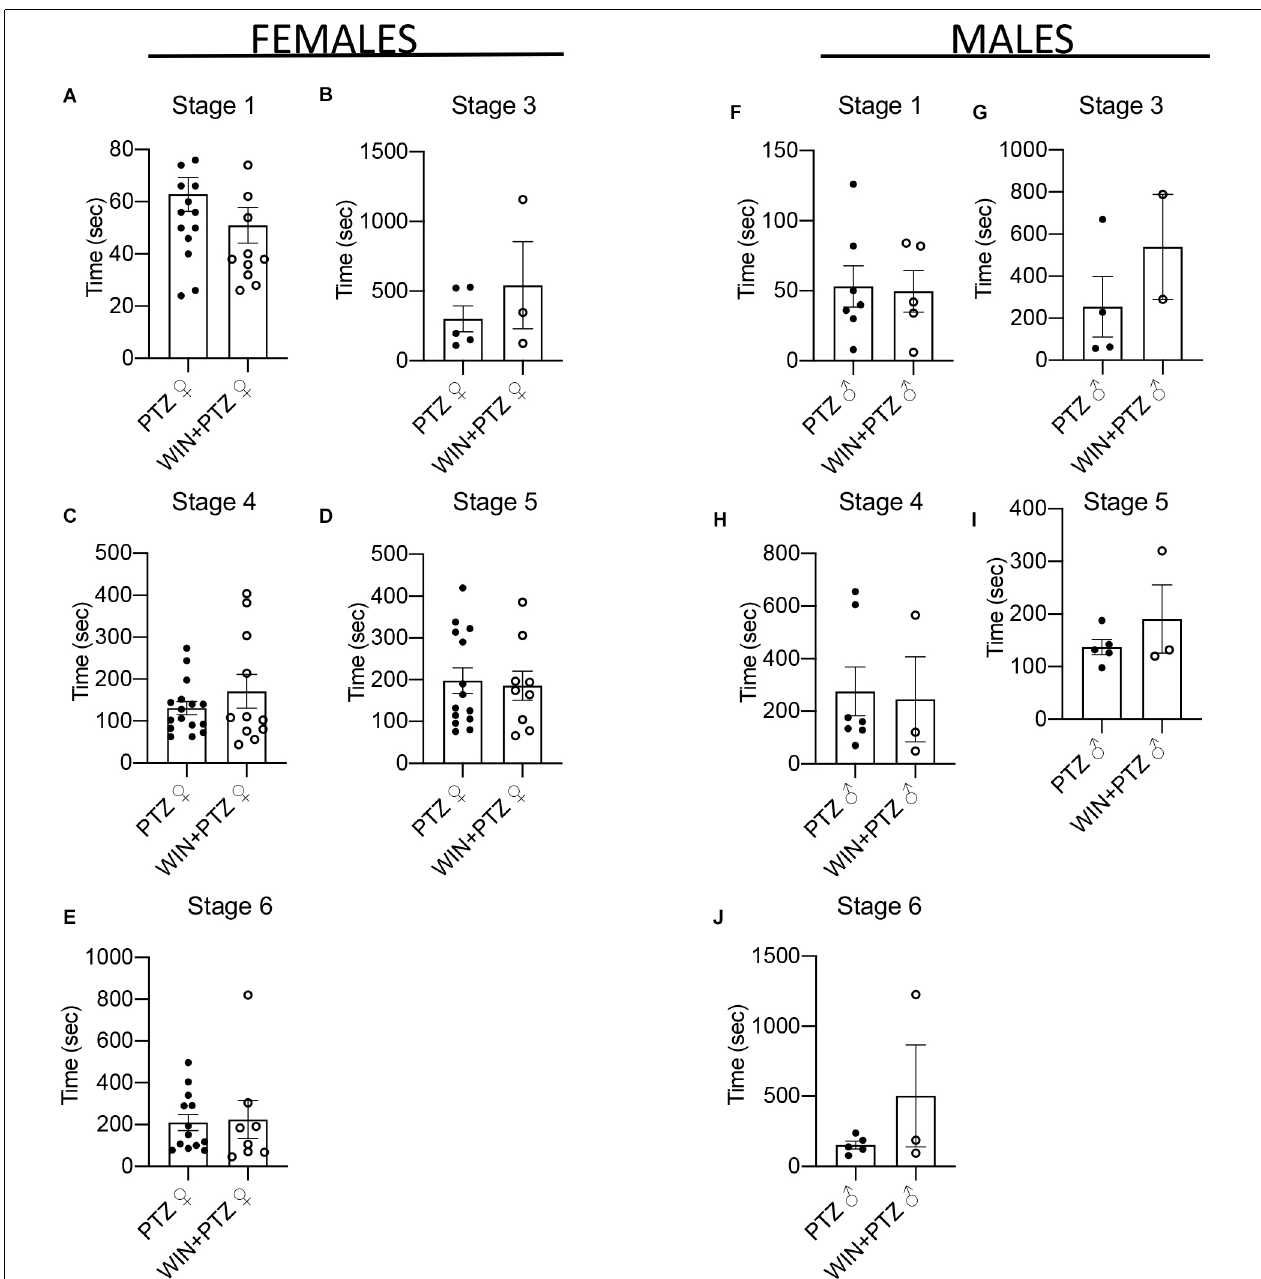
FIGURE 2 | Latency to epileptic crisis at stages of increasing severity. (A–E) Latency in females (PTZ: n = 16 for stages 1 and 4, n = 5 for stage 3, n = 14 for stage 5, n = 13 for stage 6. WIN + PTZ: n = 12, 11, 9, and 8 for stages 1, 4, 5, 6, respectively, n = 3 for stage 3). (F–J) Latency to epileptic crisis at stages of increasing severity in males (PTZ: n = 7 stages 1 and 4; n = 4 for stage 3, n = 5 for stages 5 and 6. WIN + PTZ: n = 5 for stage 1, n = 2 for stage 3, n = 3 for stages 4, 5, and 6).